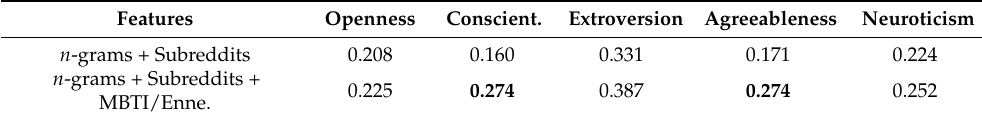
Table 16. The Pearson correlation coefficient between the actual Big Five traits and predictions achieved through usage of n -grams, MBTI/Enneagram predictions and subreddit participation in the feature set.